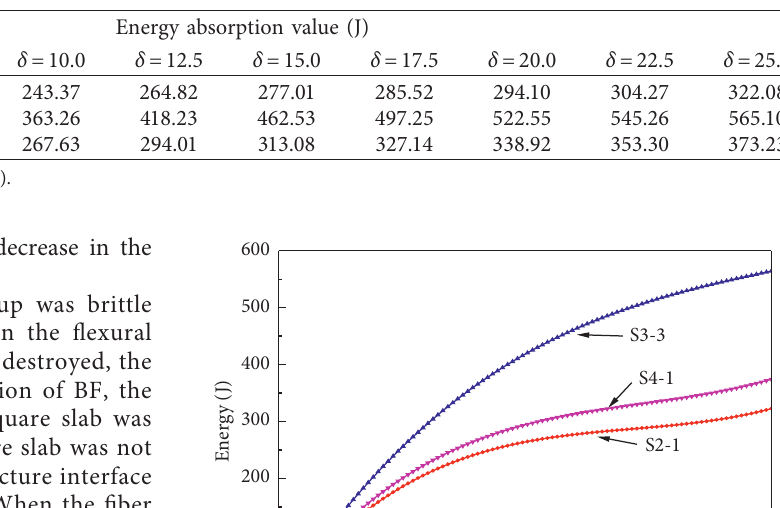
Table 5: Effect of BF on energy absorption of shotcrete square slabs.